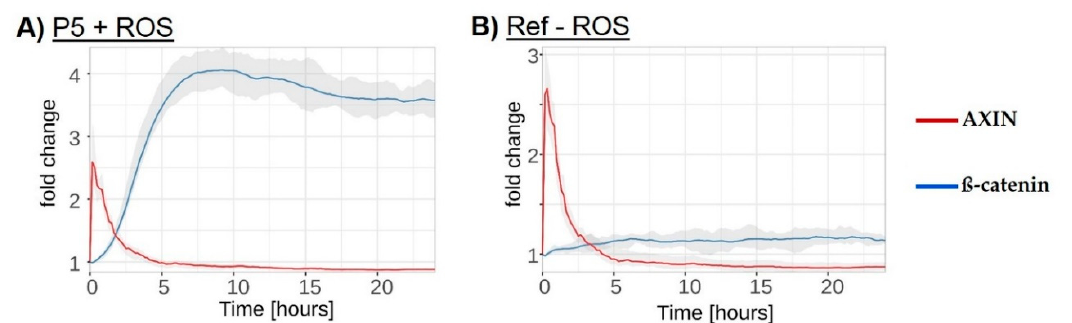
Figure 8. Simulation result of the fitted model showing the concentration fold change of total β -catenin (blue) and AXIN expression (red) on ( A ) P5, and ( B ) Ref. The grey area depicts the mean deviation between individual simulation runs for each time point. ( A ) The simulation of the model with higher reactive oxygen species (ROS) production, as observed on P5 (see Figure 6), results in a moderate accumulation of β -catenin, whereas the target gene expression of AXIN stays constant after a short initial increase. ( B ) The simulation of the model with no ROS production, in contrast to P5. Here was observed a small, but not significant accumulation of β -catenin, while the target gene expression of AXIN stays constant after a short initial increase (similar to P5).